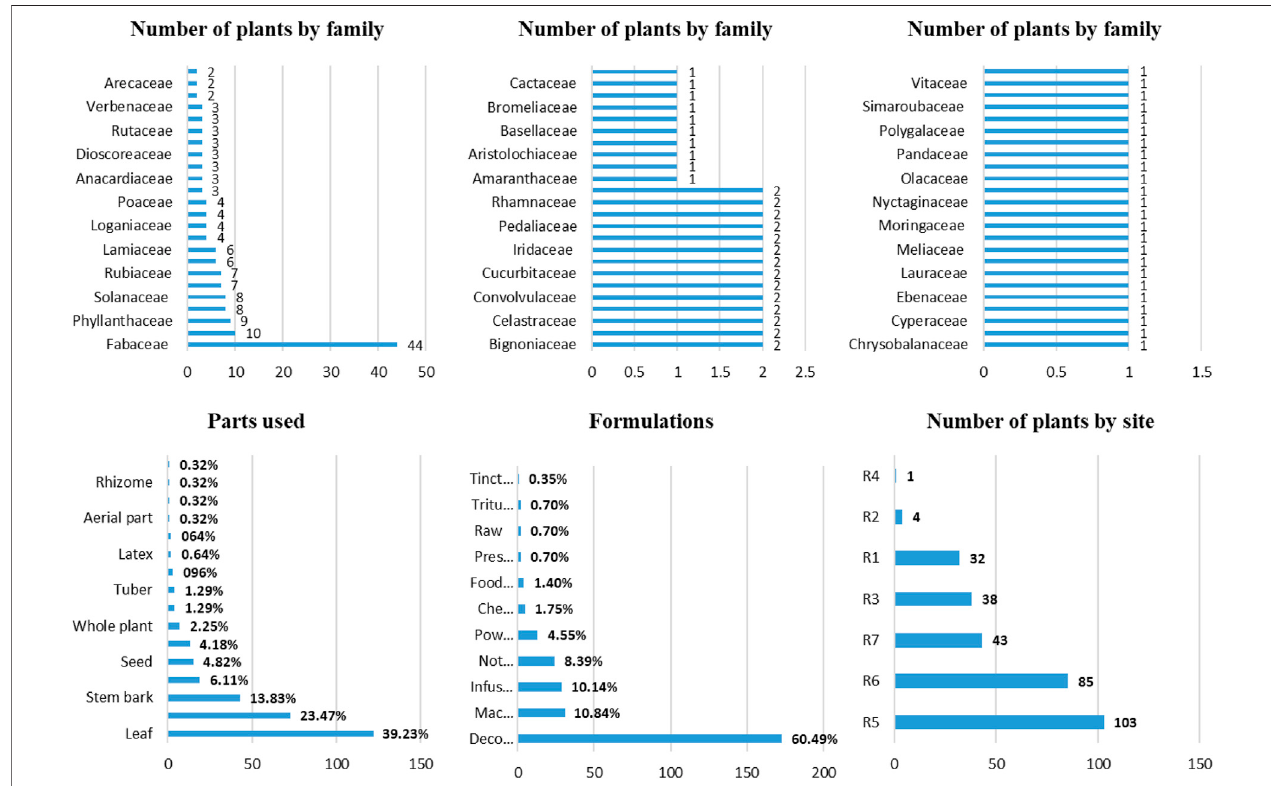
FIGURE 4 | Frequencies of antidiabetic plants in DRC by botanical families, parts used, formulations, and sites.